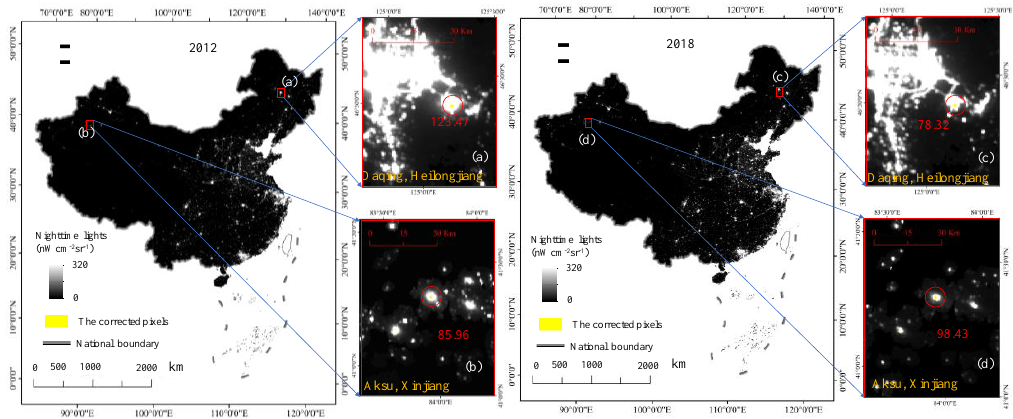
Figure 5. The corrected NPP-VIIRS data in China. (a) the corrected valve in Daqing, Heilongjiang in 2012; (b) the corrected valve in Aksu, Xinjiang in 2012; (c) the corrected valve in Daqing, Heilongjiang in 2018; (d) the corrected valve in Aksu, Xinjiang in 2018.